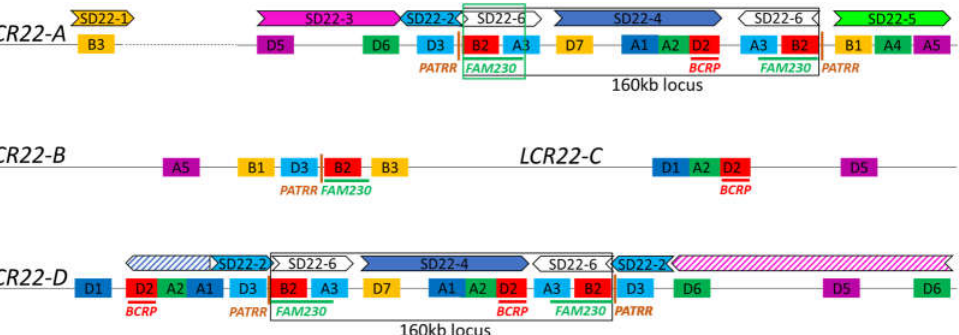
Figure 4. Recombination loci on the LCR22 map. The four proximal LCR22s are depicted schemati- cally based on the fiber-FISH probe composition from Demaerel et al. (2019). LCR22-A is represented as the smallest haplotype including all possible SD22 duplicons. The dotted line reflects the variability in size, copy number, and composition. The SD22 duplicons are illustrated above the fiber-FISH probe compositions of LCR22-A and -D. The BCR module [35,36], FAM230 [33], PATRR [16], and 160 kb locus [32] are indicated in the LCR22s. Drawings are not to scale.